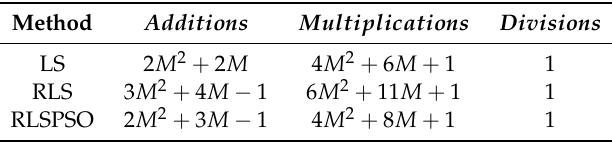
Table 5. Complexity of Algorithms per input